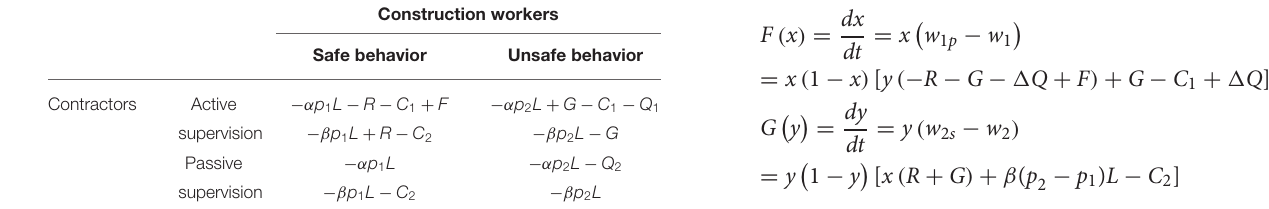
TABLE 2 | The payoffs matrix of contractors and construction workers. Construction workers Safe